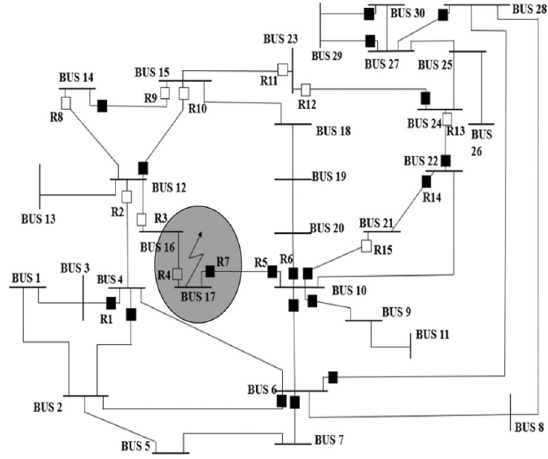
Fig. 8 IEEE 30-bus system with breakpoints and fault at bus 17